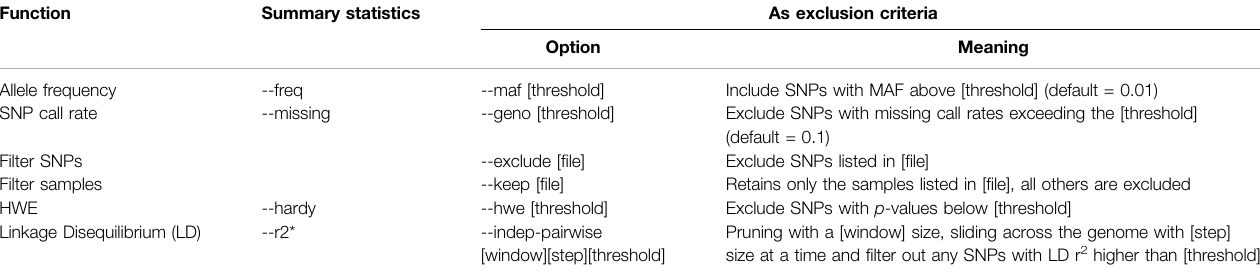
TABLE 3 | PLINK 2 commands for summary statistics and fi